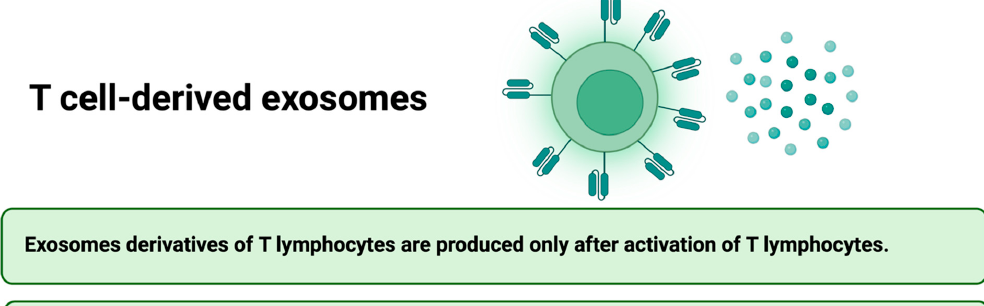
Figure 6. Advantages of combined CARs and Cell ‐ Derived EVs therapy [58,141].